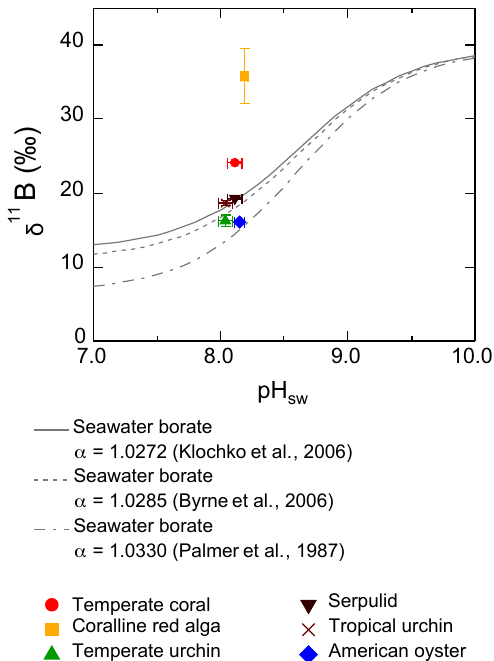
Figure 4. Boron isotopic composition ( ± SD) of different species of marine calcifiers as a function of seawater pH ( ± SD). The six species shown in this figure were grown under controlled p CO 2 conditions of ca. 409ppm. Grey lines are theoretical seawater δ 11 B –pH curves based on different α that have been used to B ( OH ) − 4 describe boron isotope fractionation between borate ion and boric acid in seawater (using pK B of 8.6152 at 25 ◦ C and 32psu). Al- though α = 1.0272 (Klochko et al., 2006) is presently the most com- monly used α , δ 11 B –pH curves calculated from other values B ( OH ) − 4 of α are also shown for